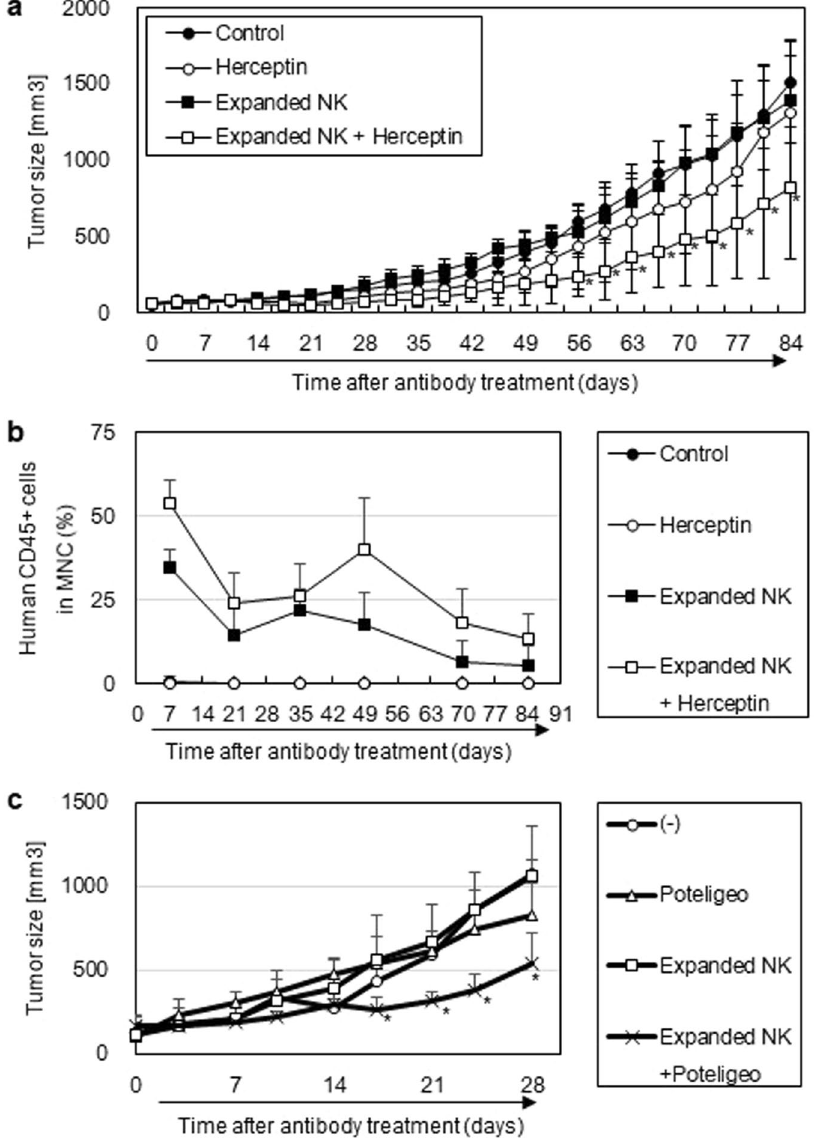
Figure 7. In vivo antibody-dependent cell-mediated cytotoxicity (ADCC) activity in hu-PB-NK in NOG-IL-15 Tg mice. ( a ) Tumor suppression by in vitro -expanded hu-PB-NK cells and anti-Her2 treatment. Her2-positive NCI-N87 cells, a gastric-cancer cell line, were inoculated into X-irradiated-NOG-IL-15 Tg mice. Hu-PB-NK in vitro- cultured cells were transplanted with or without anti-Her2 antibody, as described in the Methods and Supplementary Fig. S5. Tumor growth (mean ± SD) is shown. * Indicates statisitical significance detected by Tukey’s multiple comparisons test with 95% confidence interval. ( b ) Persistence of transfused human NK cells in NOG-IL-15 Tg mice over the experimental period. ( c ) Tumor suppression by in vitro -expanded hu-PB-NK cells and anti-CCR4 treatment.NOG-IL-15 Tg mice were X-irradiated and subsequently inoculated with L428 (5 × 10 6 ). In vitro -expanded hu-PB-NK cells (6 × 10 6 ) were transplated 1 week after tumor inoculation and administration of anti-CCR4 antibody (100 μ g) or control antibody was started. The antibody treatment were repeated twice a week for up to 4 weeks. Tumor size in NOG-IL-15 Tg (n = 3) or hu-PB-NK NOG-IL-15 Tg mice (n = 3), which were treated with anti-CCR4 antibody or control antibody, was monitored for 4 weeks. * Indicates statisitical significance between the non-treated group and the combined therapy received group. The p-value was obtained using Student’s t -test ( * p <